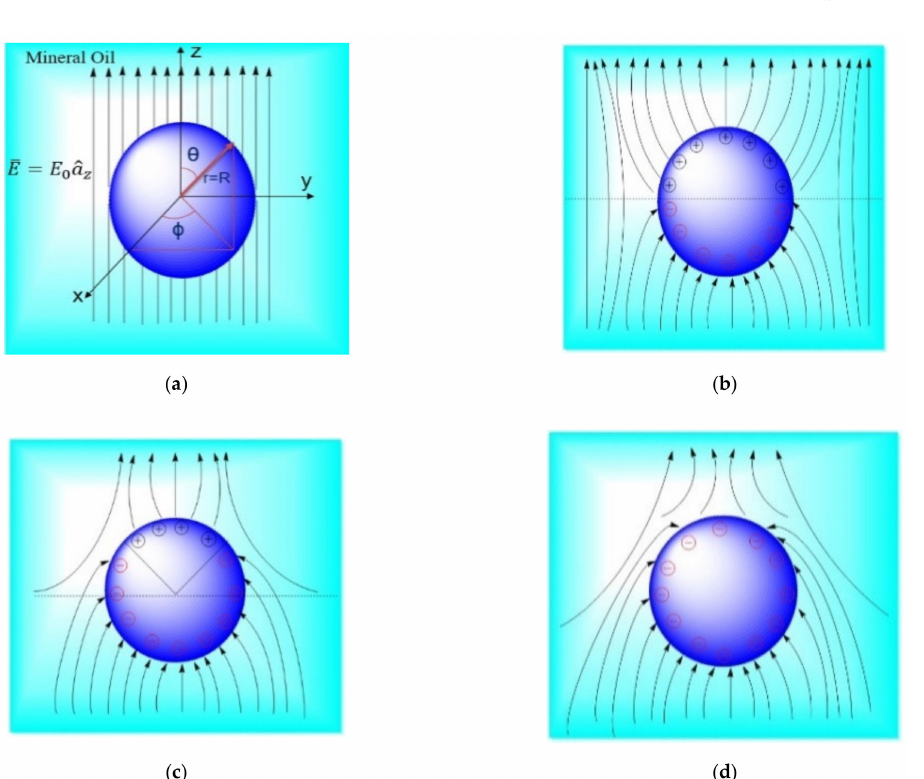
Figure 8. Charging of the NP ( a ) particle exposed to an external field, ( b ) ionization or polarization of the NP, ( c ) depletion of the positive ions, and ( d ) complete depletion of the positive